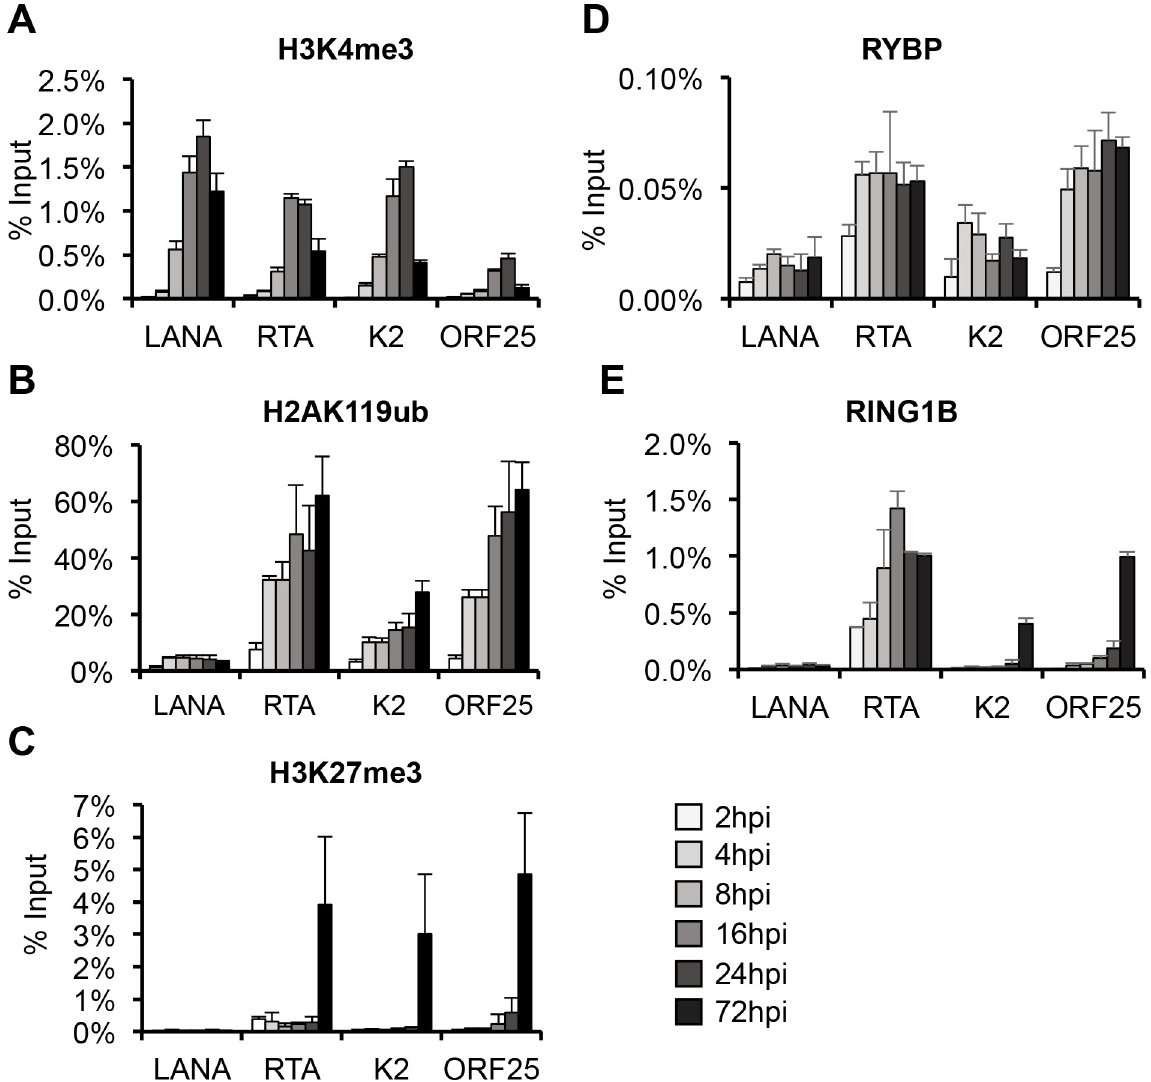
Fig 3. Analysis of the enrichment of histone modifications and the binding of PRC1 factors on KSHV promoters during de novo KSHV infection. SLK cells were infected with KSHV, and ChIP-qPCR analysis was performed on LANA, RTA, K2, ORF25 promoters at the indicated time points for (A) H3K4me3, (B) H2AK119ub, (C) H3K27me3, (D) RYBP, and (E)